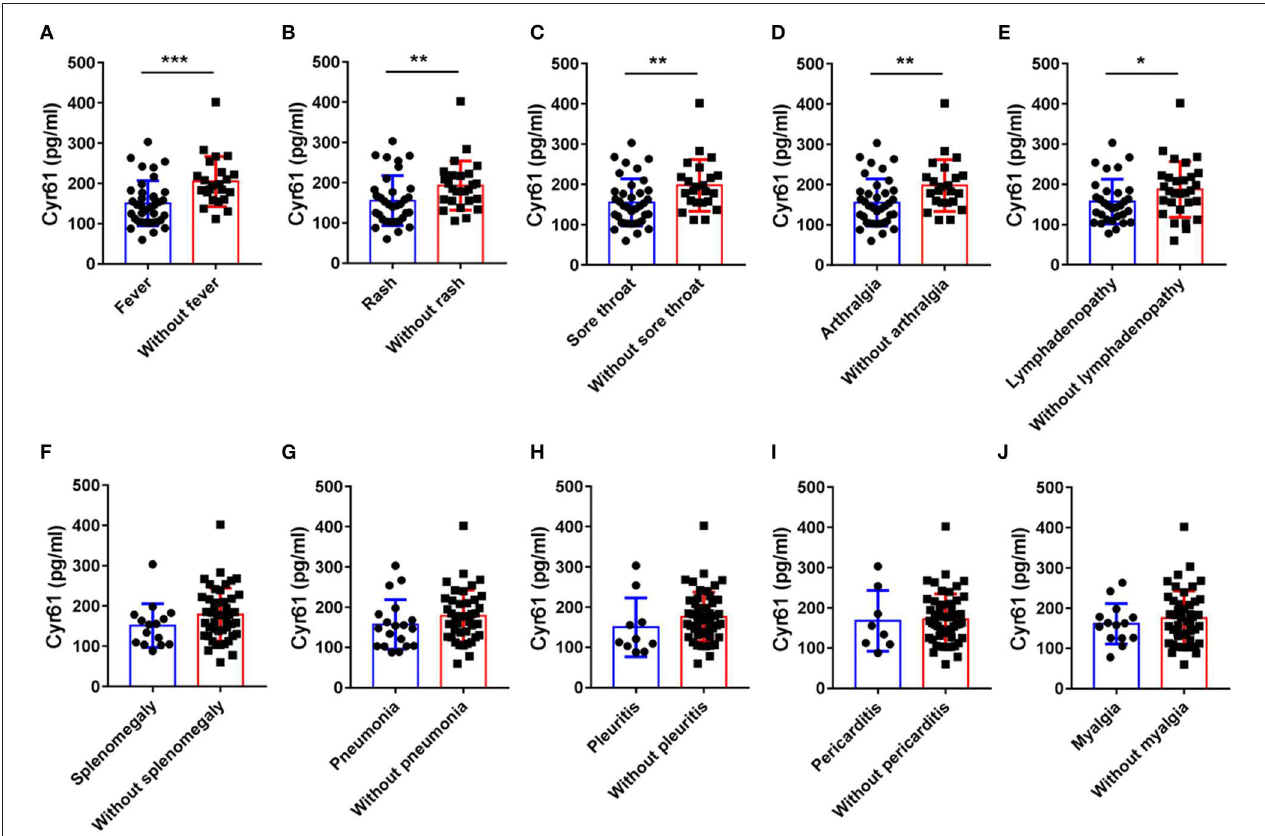
FIGURE 3 | The serum levels of cysteine-rich angiogenic inducer 61 (Cyr61) according to disease manifestations in adult-onset Still’s disease (AOSD) patients are shown. The serum levels of Cyr61 in AOSD patients with (•) or without ( (cid:4) ) the symptoms of fever (A) , skin rash (B) , sore throat (C) , arthralgia (D) , lymphadenopathy (E) , splenomegaly (F) , pneumonia (G) , pleuritis (H) , pericarditis (I) , and myalgia (J) are shown. The non-parametric Mann–Whitney U -test was used to compare differences between each group, and data represent median with interquartile range (IQR). * P < 0.05, ** P < 0.01, *** P <